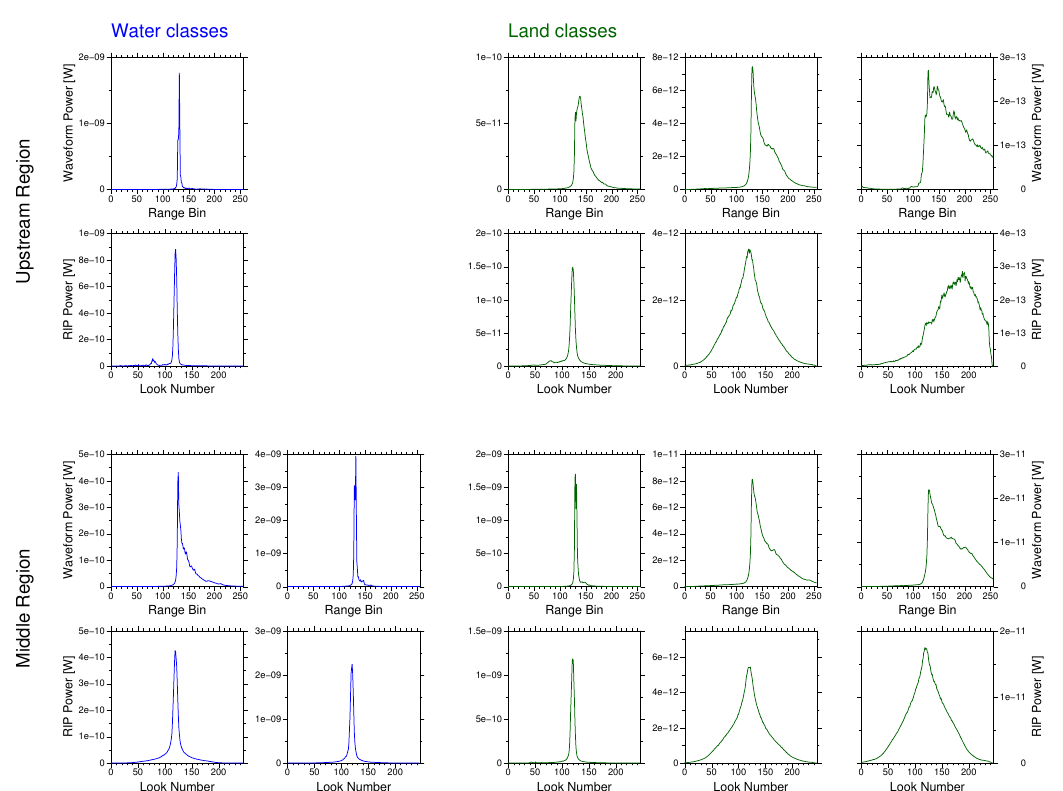
Figure 5. The mean waveforms and RIP of some selected classes; the waveforms and RIP above each other belong to the same class.